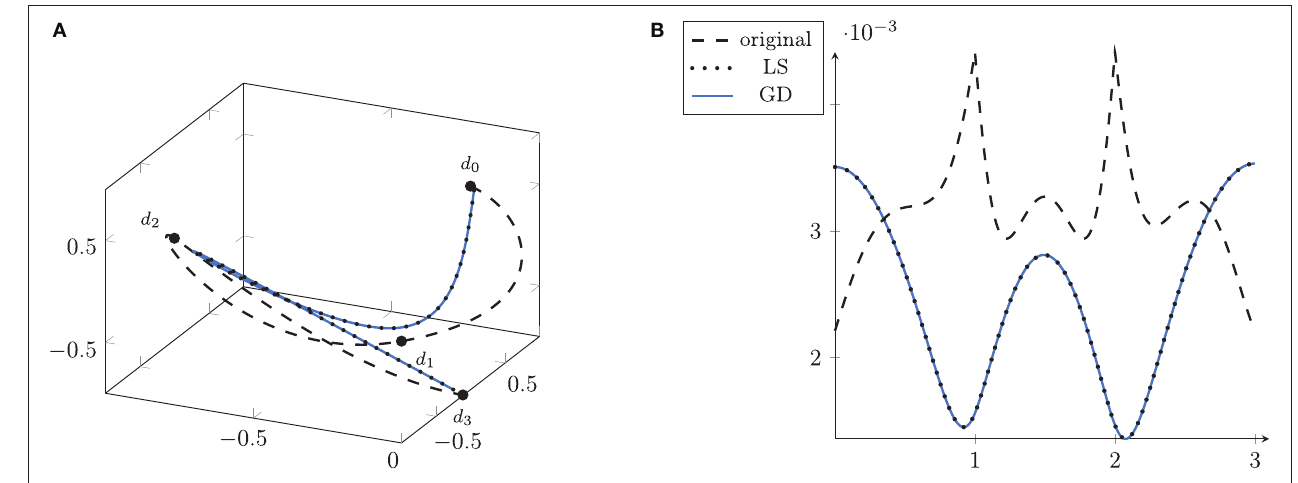
FIGURE 7 | The initial interpolating Bézier curve in R 3 (dashed, A ) with an MSA of 18.8828 is optimized by the linear system method (LS) from [ 37] (dotted) and by the proposed gradient descent (GD, solid blue). As expected, both curve coincide, with an MSA of 4.981218. The correspondance is further illustrated with their first order differences in (B) .